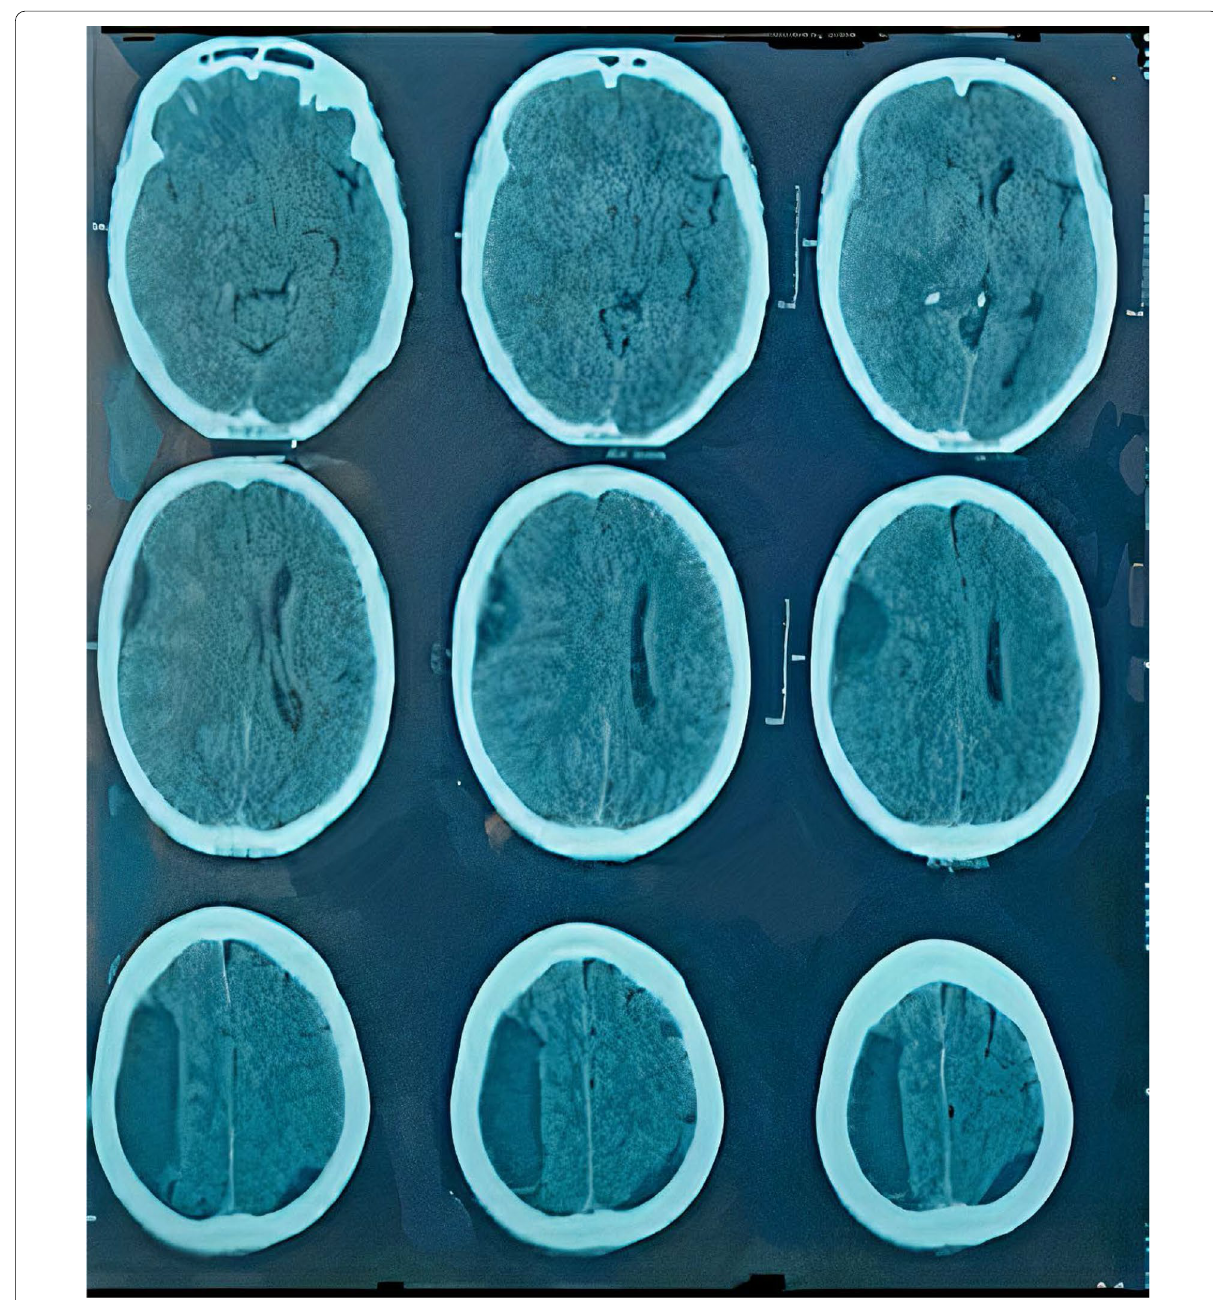
Fig. 1 CT scan brain: right temporal, parietal hypodense lesion and left parietal